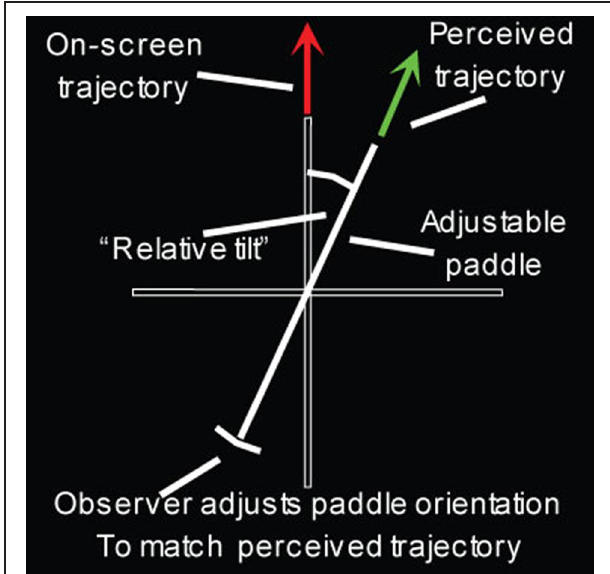
FIGURE 3 | The adjustable onscreen gauge [reproduced from Warren et al. (2012)]. The red arrow represents the actual trajectory of the probe, with the green arrow the observer’s perceived probe